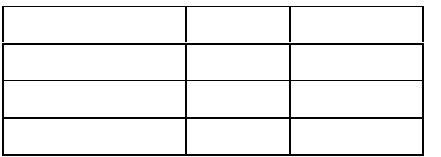
Table: 2 Diagnosis at the time of first HD